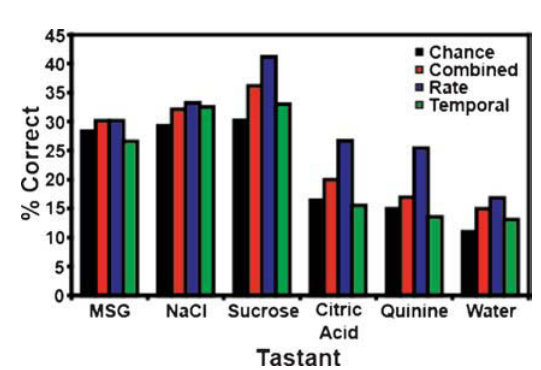
Figure 11. Tastant classifications for the unreinforced lick data. The con- ventions for this figure are the same as those in Figure 7 . Both the combined and rate models correctly classified all tastant types above the weighted chance levels, but the temporal model failed to identify MSG, citric acid, and